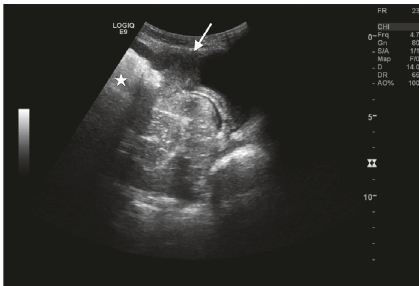
Figure 1: Sagittal US image of the lower abdomen obtained with a convex probe (1–6Mhz). Large mass filled with gas (star), contacting the superior bladder wall (arrow), with focal thickening. Presence of free abdominal fluid is noted.